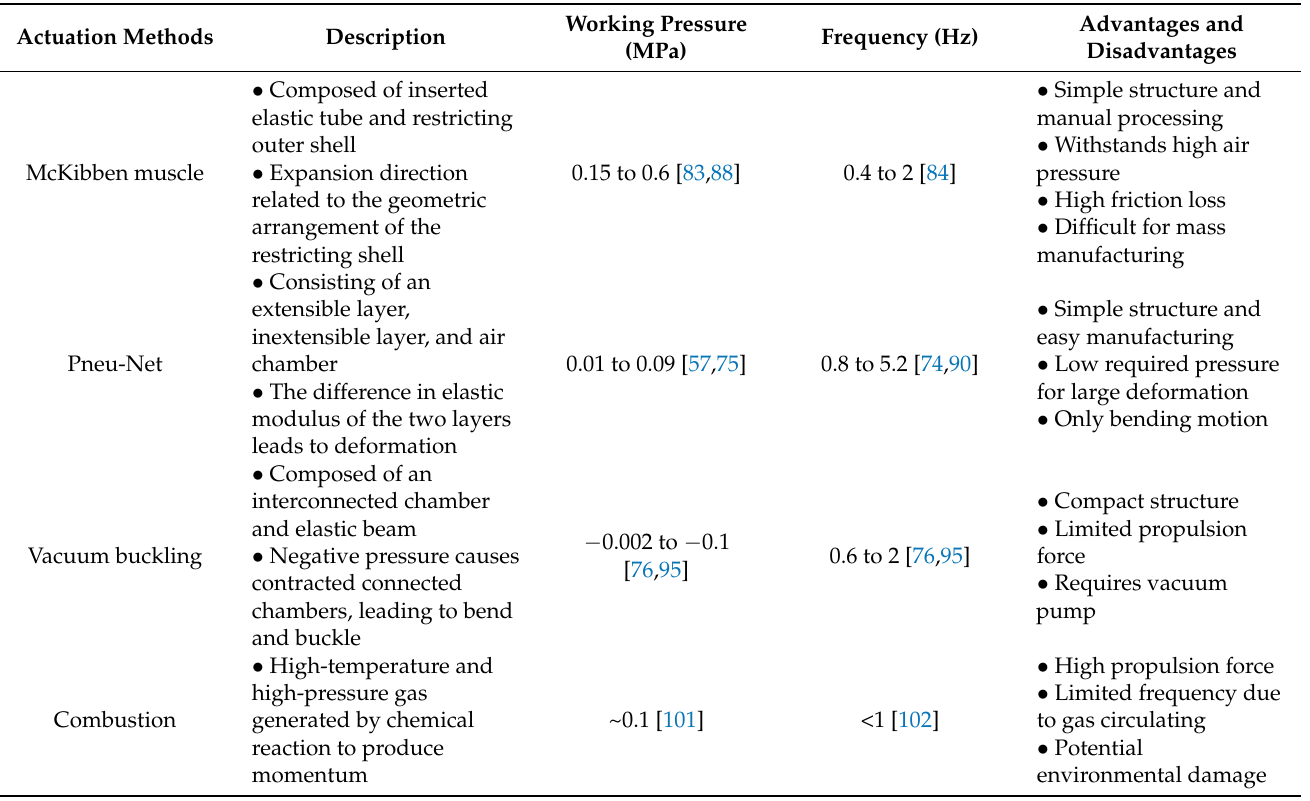
Table 3. Description of various actuation methods and their working pressure, frequency, advantages, and